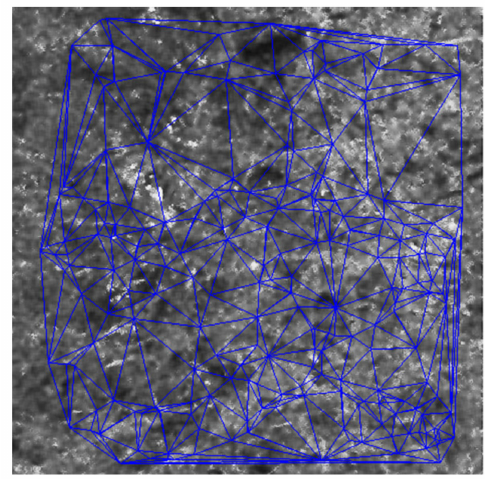
Figure 4. Constructed a triangular network by the Delaunay Triangulation